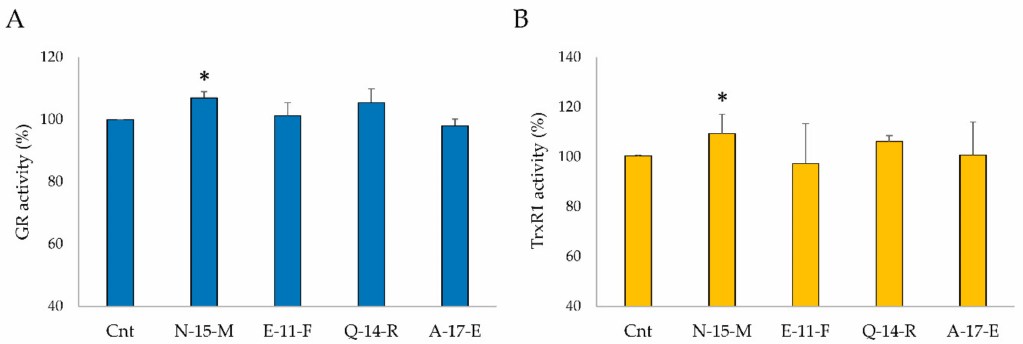
Figure 6. GR ( A ) and TrxR1 ( B ) activities in Caco-2 cells treated with N-15-M , E-11-F , Q-14-R and A-17-E (0.05 mg / mL). The activity of the two antioxidant enzymes was analyzed in Caco-2 cells treated with the four peptides for 24 h. Means of at least four experiments were compared with the control. (* p <